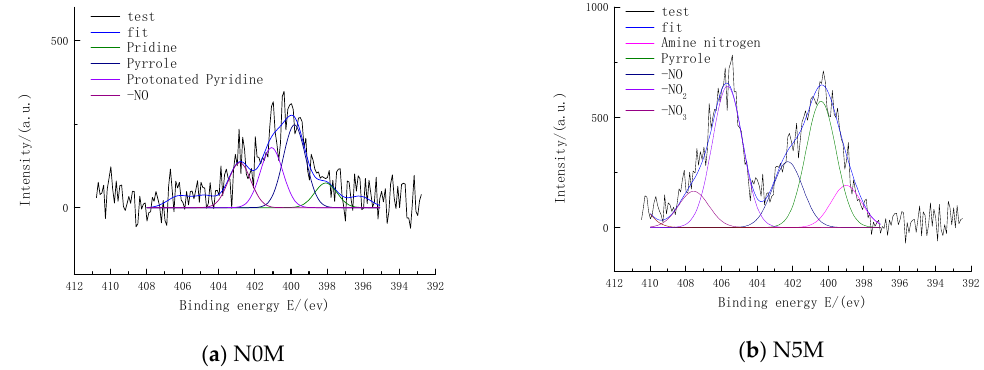
Figure 10. XPS N1S spectra for lignite and nitric acid-modified